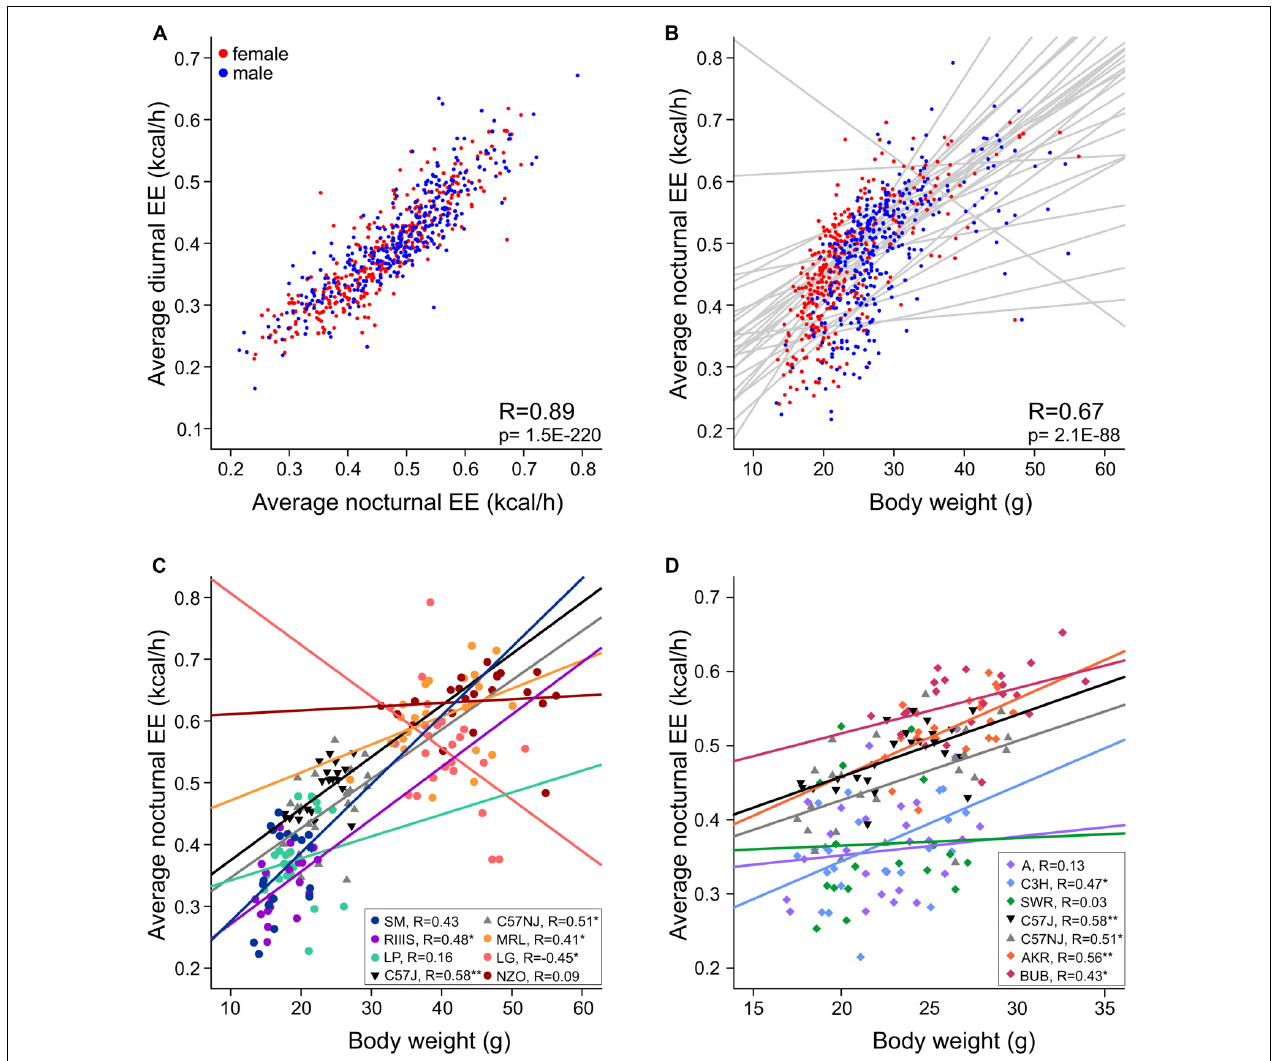
FIGURE 8 | Regression slope visualization of strain-associated effects on EE. (A) Nocturnal and diurnal EE are highly correlated. (B) Nocturnal EE plotted against body mass with the regression lines for the 30 strains in gray shows striking interaction effects. (C,D) Differences in EE plotted for strains with opposite phenotypes for body mass (C) or opposite phenotypes for EE but similar body mass (D) illustrates non-homogeneity of the regression slopes suggesting that strain-differences in EE are not the same for all body weights. Pearson’s R are indicated for the respective strains to describe the magnitude of the respective linear relationship between EE and body mass. The asterisks indicate the level of significance (* p < 0.05, ** p <